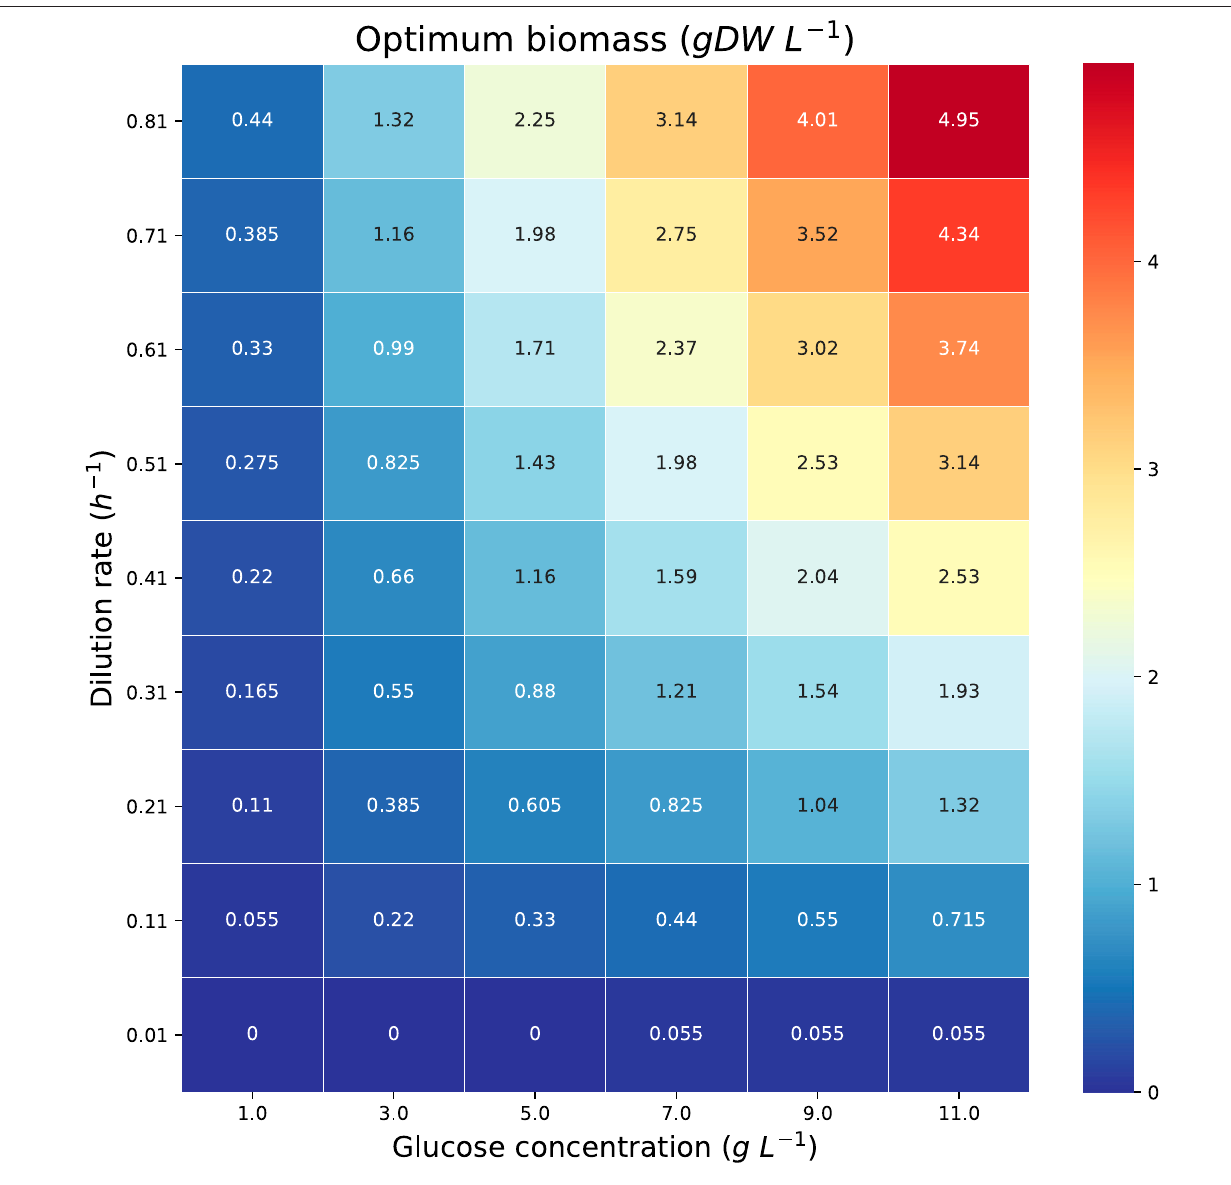
Frontiers in Molecular Biosciences |